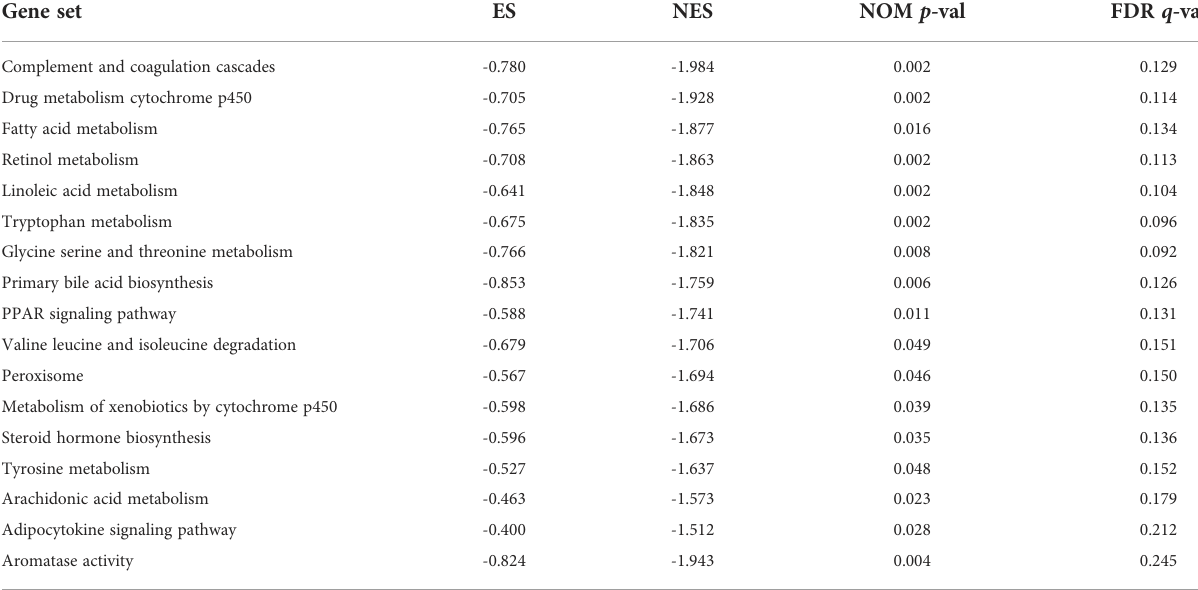
TABLE 2 The high-risk group enriched gene